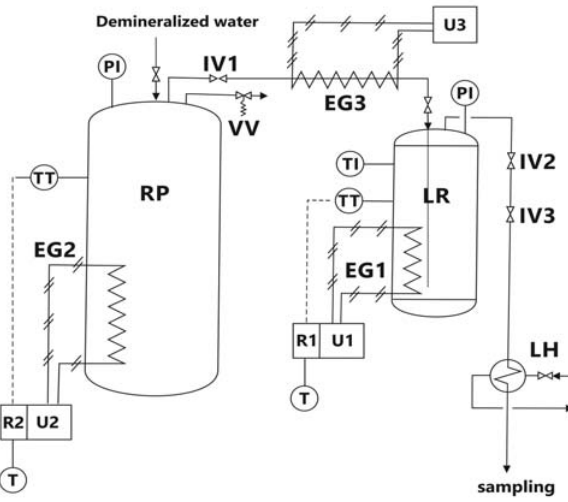
Figure 2. Scheme of the laboratory apparatus used for hydrother- mal processing of leached chestnut-wood chips. Legend: LR- reactor Ernst Haage 1220, RP – steam producer, LH – cooler, IV1, IV2, IV3- needle valves, VV – safety valve, EG1, EG2, EG3 – electric heater, U1, U2, U3 – switched-mode power supply, R1, R2 – temperature controller, PI – pressure indicator, TI – temper- ature indicator, TT – temperature transmitter, T – temperature